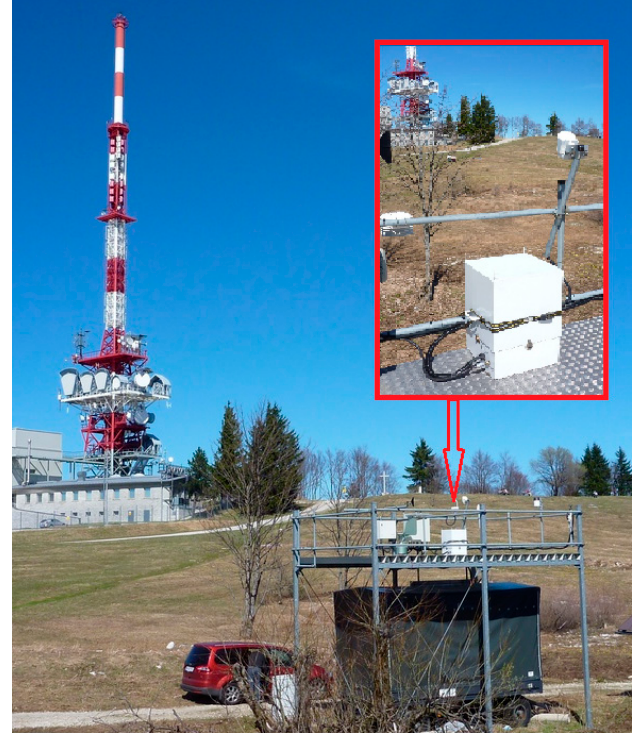
Figure 1. Gaisberg Tower and the X-ray measurement system are shown in the picture. In addition to the X-ray detector (also shown in the zoomed-in box), vertical fast E-field antenna, the field mill, and other meteorological instruments are located on the roof of the structure shown. The EMC cabinet containing the measuring equipment is also visible inside the structure. The shunts, measuring the current, are located at the tower top.